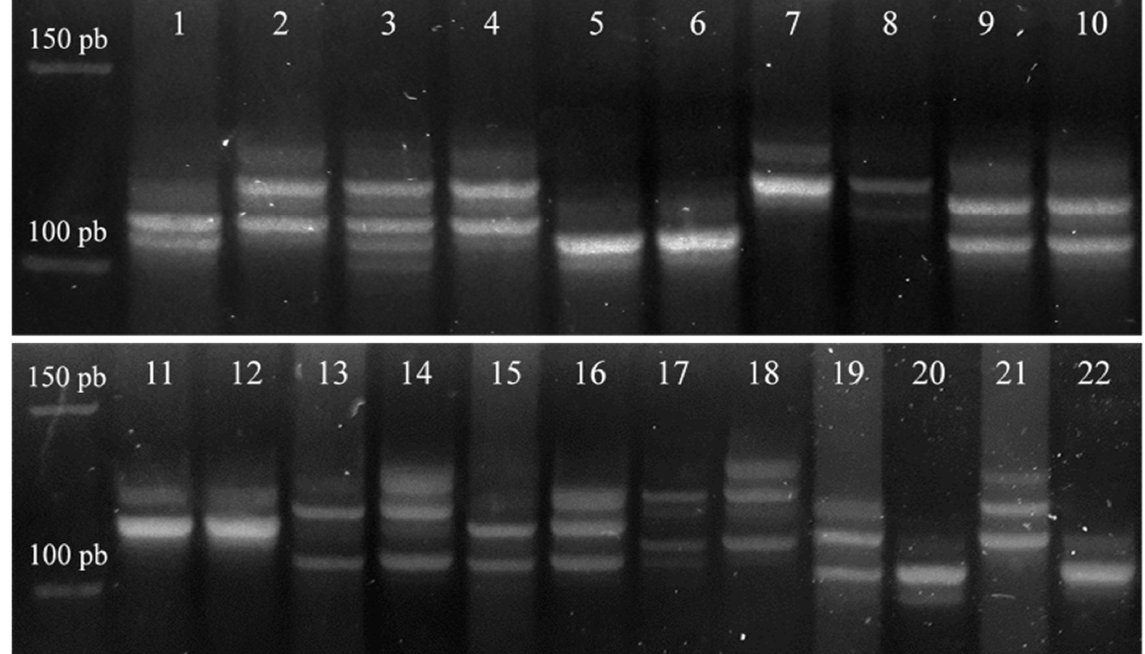
Figure 2. Examples of genetic changes in the CDH1 and CDH2 genes recorded by the microsatellite markers in meningioma samples on Spreadex gels (Elchrom Scientific, AL-Diagnostic GmbH, Amstetten, Austria). Odd numbers represent tumor DNA while even numbers represent the blood DNA of the same patient. Stripes 1 and 2—the sample shows MSI; lanes 3 and 4-the sample shows MSI; stripes 5 and 6—heterozygous sample without changes; lanes 7 and 8—the sample shows MSI; stripes 9 and 10—heterozygous sample without changes; stripes 11 and 12—heterozygous sample without change; stripes 13 and 14—the sample shows LOH; lanes 15 and 16—the sample shows LOH; stripes 17 and 18—the sample shows LOH; lanes 19 and 20—the sample shows MSI; lanes 21 and 22—the sample shows MSI.